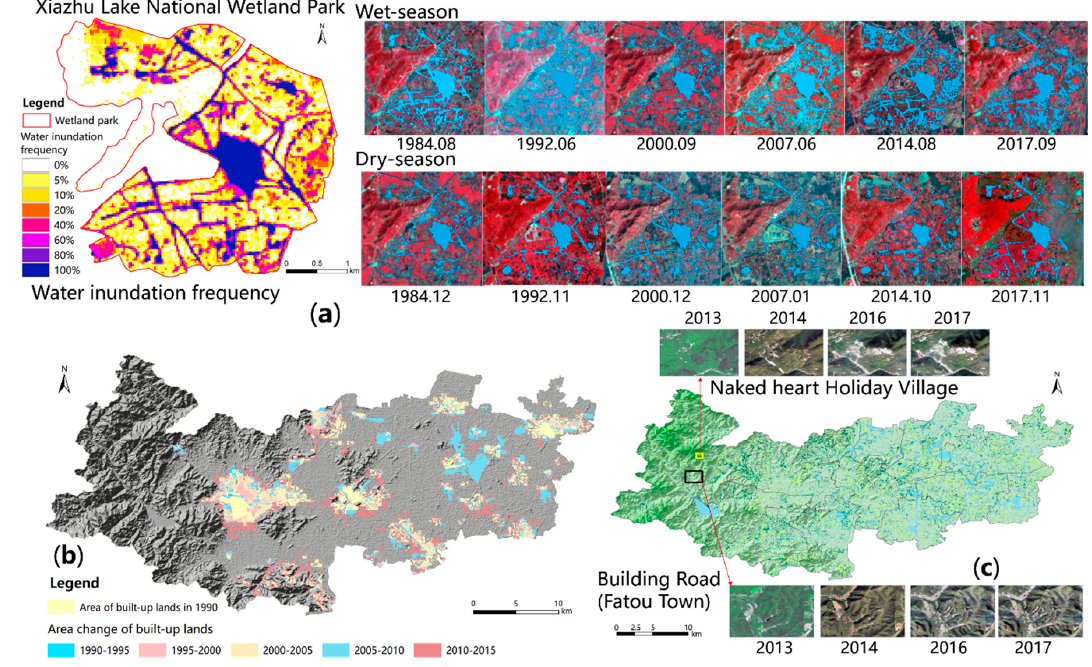
Figure4. Changemappingwithmultitemporalremotelysensedimages. ( a Figure 4. Change mapping with multitemporal remotely sensed images. ( a ) Wetland change (1984– 2017); ( b ) change of build-up area (1990–2015); ( c ) forest change (2013–2017).